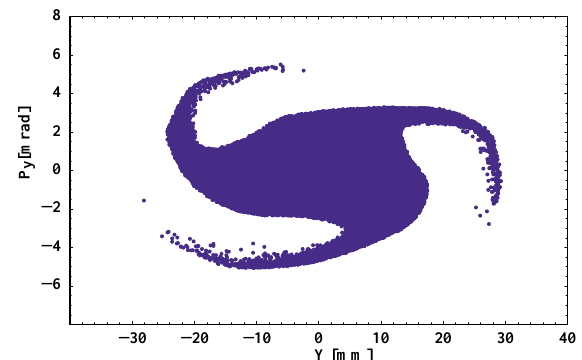
FIG. 22. (Color) Third order lattice resonance for KV beam only after 10 turns.